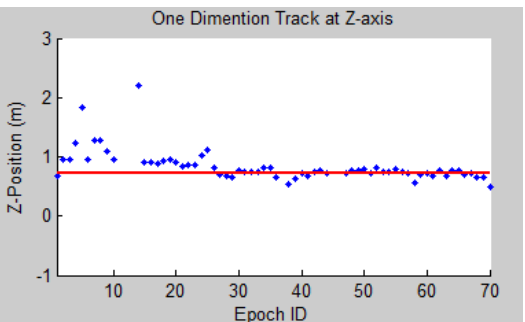
Figure 25. Z positions of indoor navigation calculated by the system (blue dots) with reference to the controlled value (red